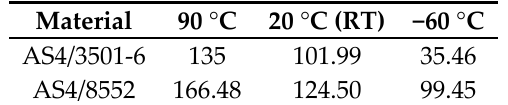
Table 1. G th (J/m 2 ) values obtained from the experimental analysis